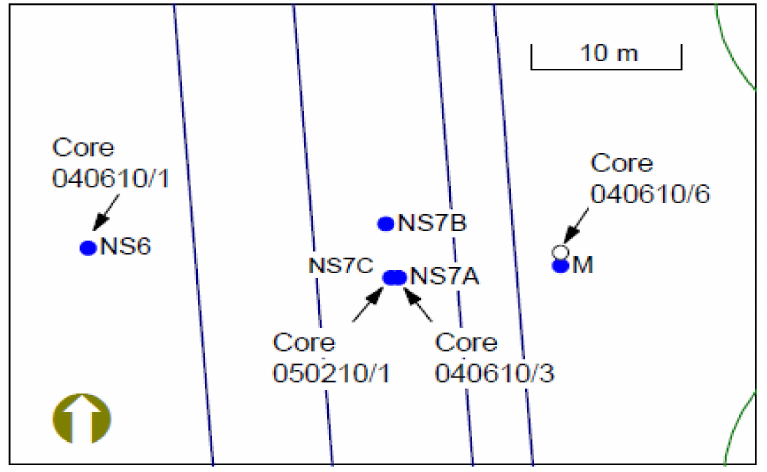
Figure 1. Locations of wells and coring at the site [16].